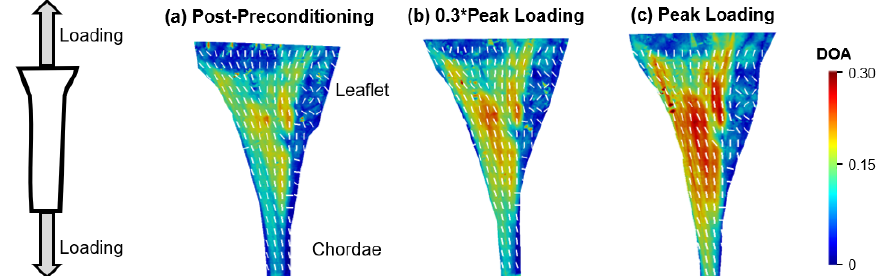
Figure 6. Quantifications of the load-dependent collagen fiber architecture of a representative porcine mitral valve strut chordae-leaflet insertion region using the polarized spatial frequency domain imaging (pSFDI) modality: ( a ) at the post-preconditioning configuration, ( b ) at intermediate loading (0.3 * peak loading), and ( c ) at the peaking loading. White, dashed lines denote the quantified collagen fiber orientation angles, and the colormaps show the degree of optical anisotropy (DOA)—a metric related to the degree of alignment for the underlying collage fiber networks (a warmer color denoting a better aligned collagen fiber network).